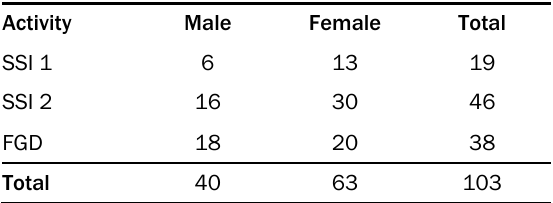
Table 1. Total Number of Participants by Sex and